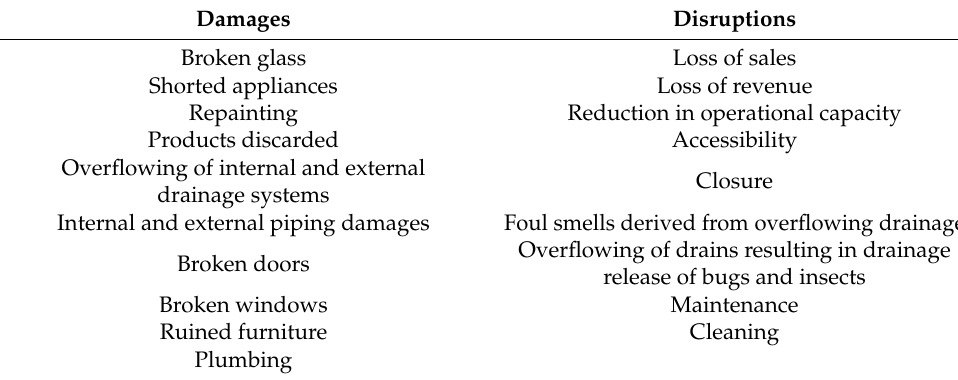
Table 2. An inventory of damages and disruptions sustained by the business communities during past coastal flooding